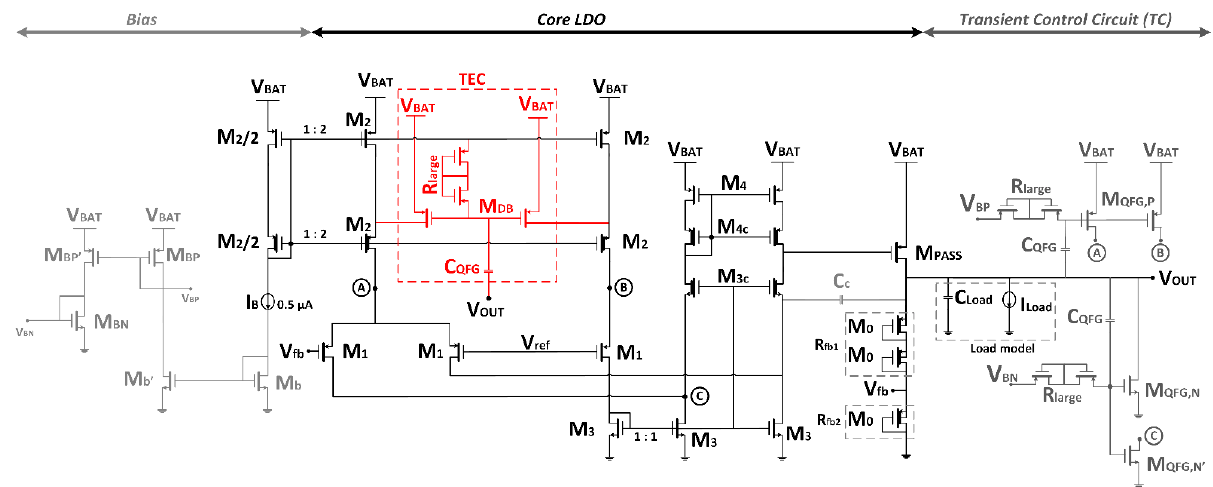
Figure 6. Core structure of the proposed low dropout regulator with transient control circuits.